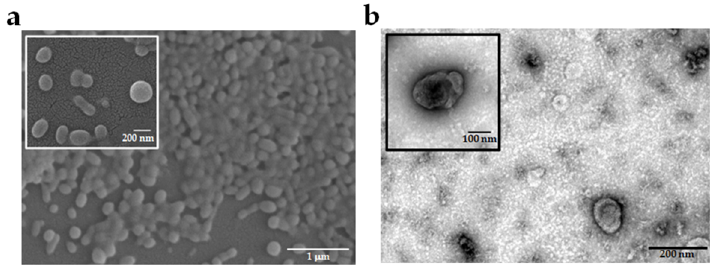
Figure 1. Representative electron micrograph of Pf -EVs isolated from a malaria culture supernatant. ( a ) Pf- MV imaged by FE-SEM at a magnification of 10,000× with a bar scale 1 μ m and 30,000× with a bar scale 200 nm (inset). ( b ) Pf -Exo imaged by TEM at a magnification of 15,000× with a bar scale 200 nm and 20,000× with a bar scale 100 nm (inset).